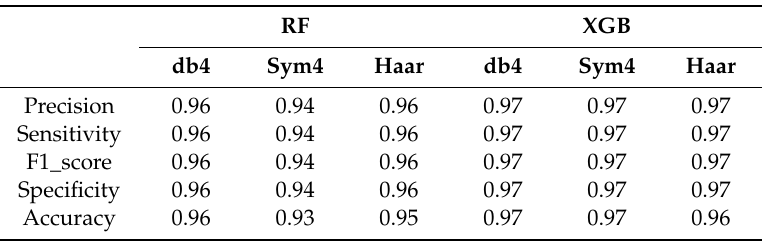
Table 6. The five evaluation parameters of two classifiers for three wavelets executed on the raw signal.